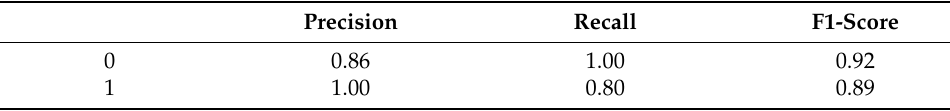
Table 5. Performance Metrics for Testing Data. Table 6. Performance Metrics for Training